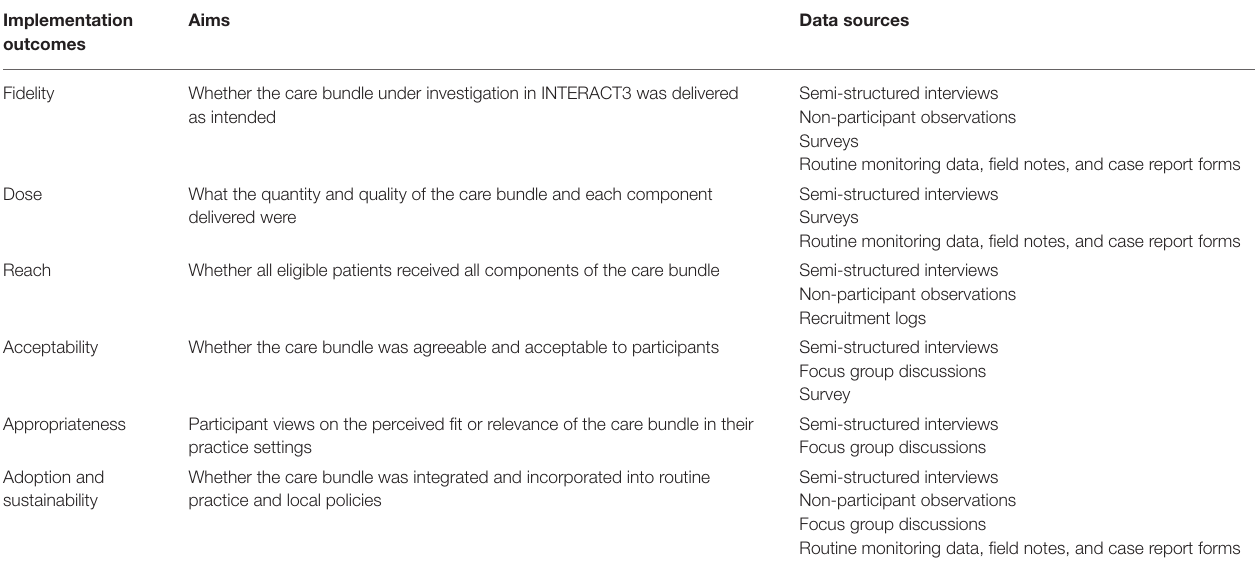
TABLE 2 | Implementation outcomes